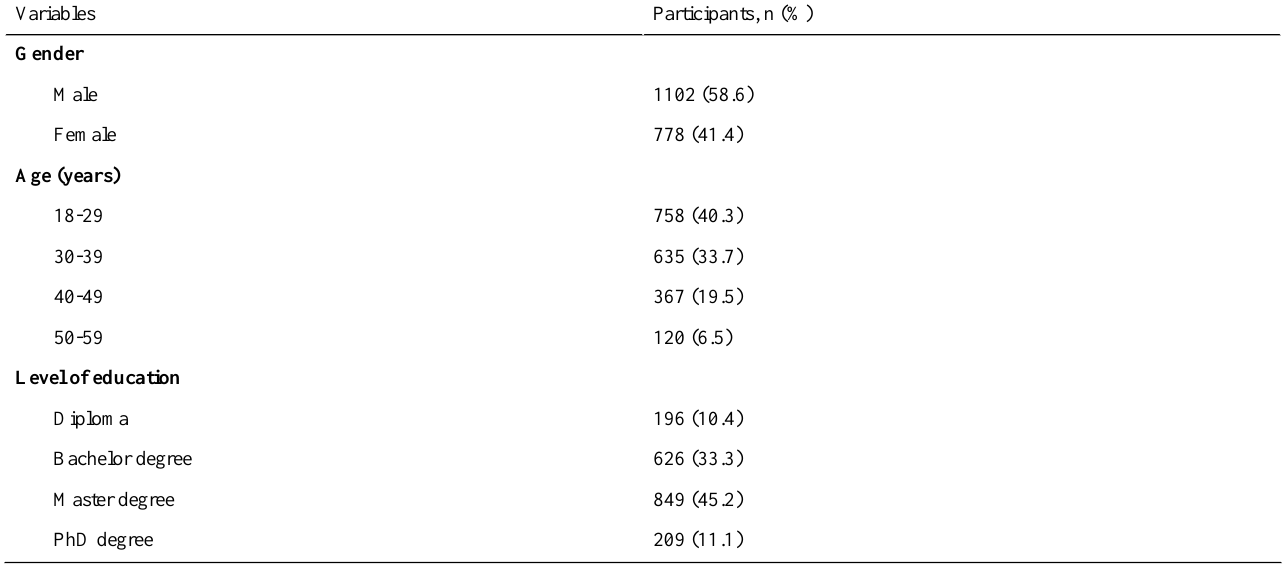
Table 2. Summary of students’demographic characteristics.